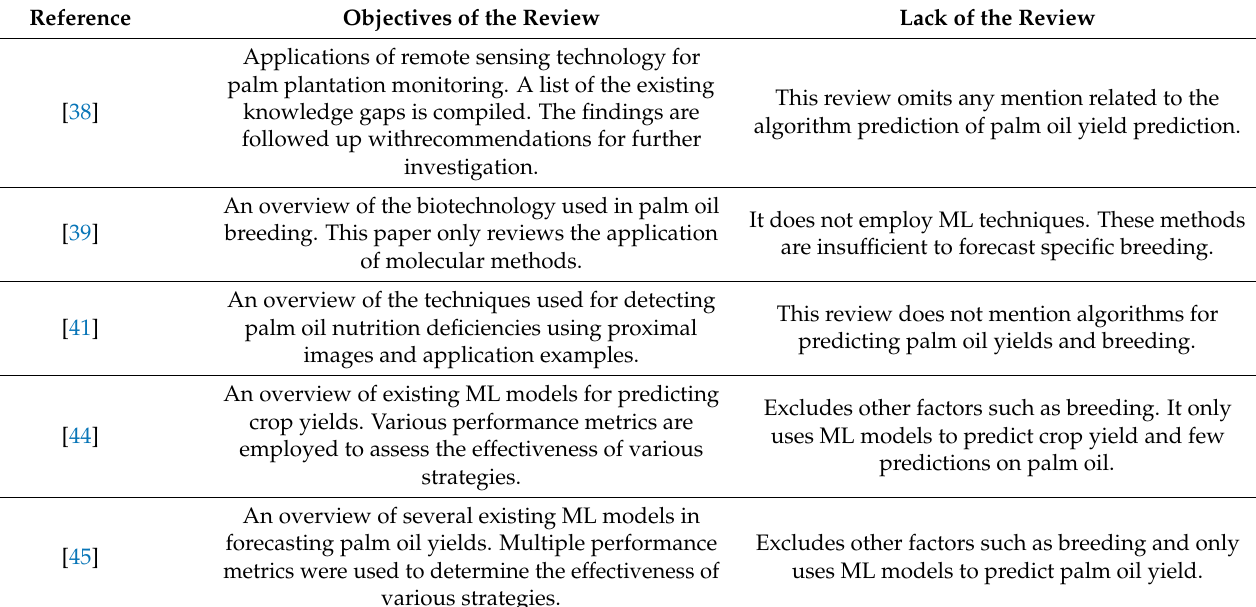
Table 1. An analysis of recent literature reviews on algorithms in palm oil yield prediction.